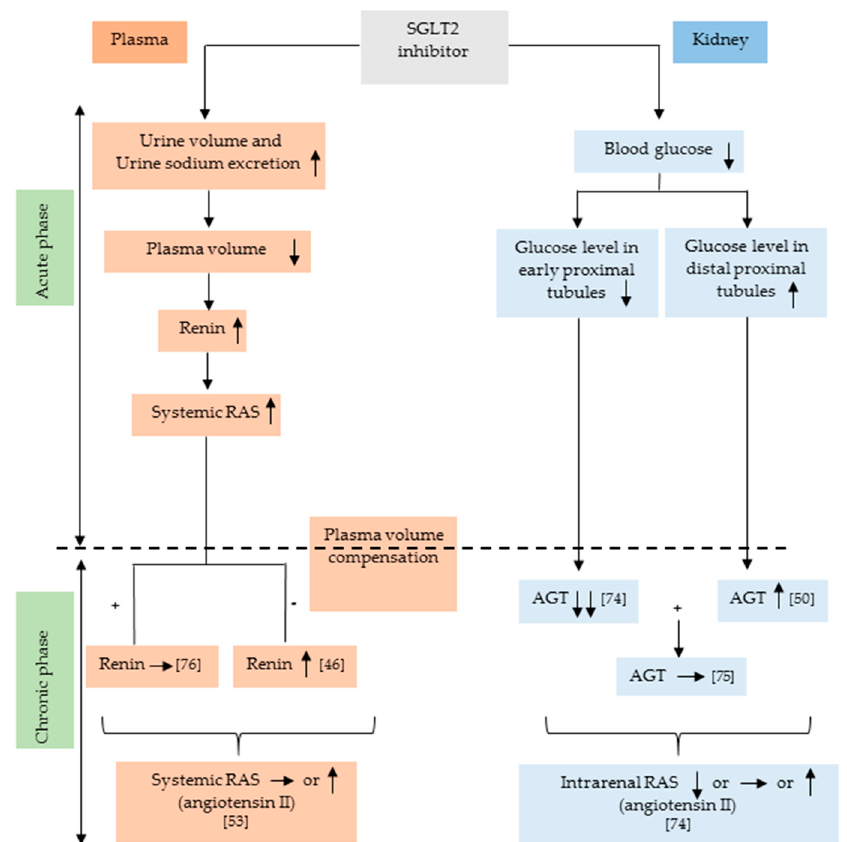
Figure 1. Possible mechanisms by which SGLT2 inhibitors influence the systemic and intrarenal RAS. SGLT2 inhibitors transiently increase plasma renin activity acutely through osmotic diuresis. Meanwhile, SGLT2 inhibitors decrease renal AGT expression by reducing glucose levels in the kidney. However, SGLT2 inhibitors can increase the glucose load in distal proximal tubule and that might increase the AGT production. SGLT2, sodium-glucose cotransporter 2; RAS, renin-angiotensin system; AGT, angiotensinogen. ↑ , increase; ↓ , decrease; → , no change; +, in case of plasma volume compensation; − , in case of no plasma volume compensation.